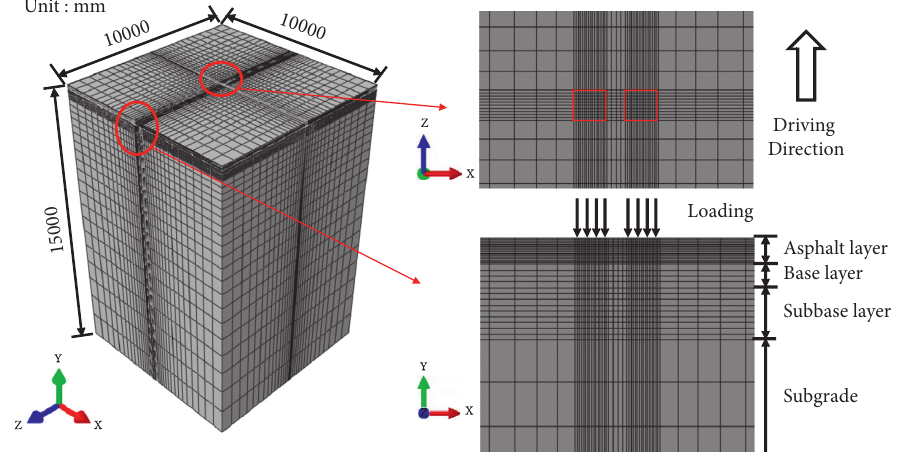
Figure 2: The finite element